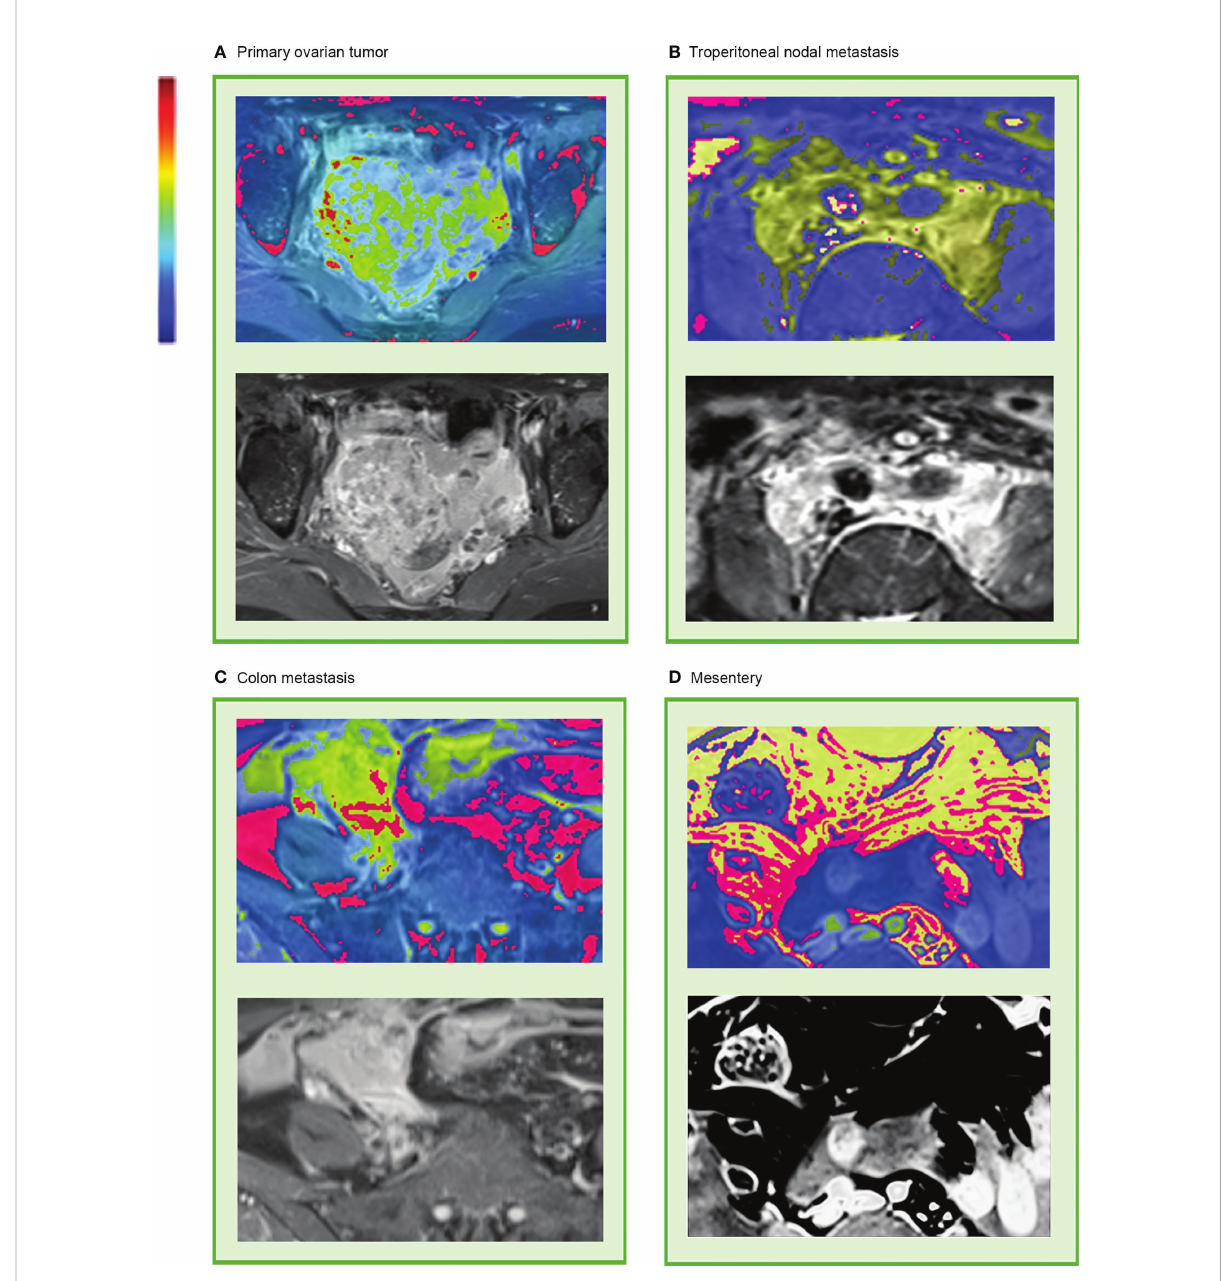
FIGURE 5 Representative heat map of deep learning feature visualization. The “ rainbow ” color scheme highlight showcases highly active areas. It can be observed that the highly active areas were focused on and overlapped with (A) primary tumor, (B) enlarged lymph nodes that surrounding the abdominal aorta and inferior vena cava, (C) colon metastasis, and (D)